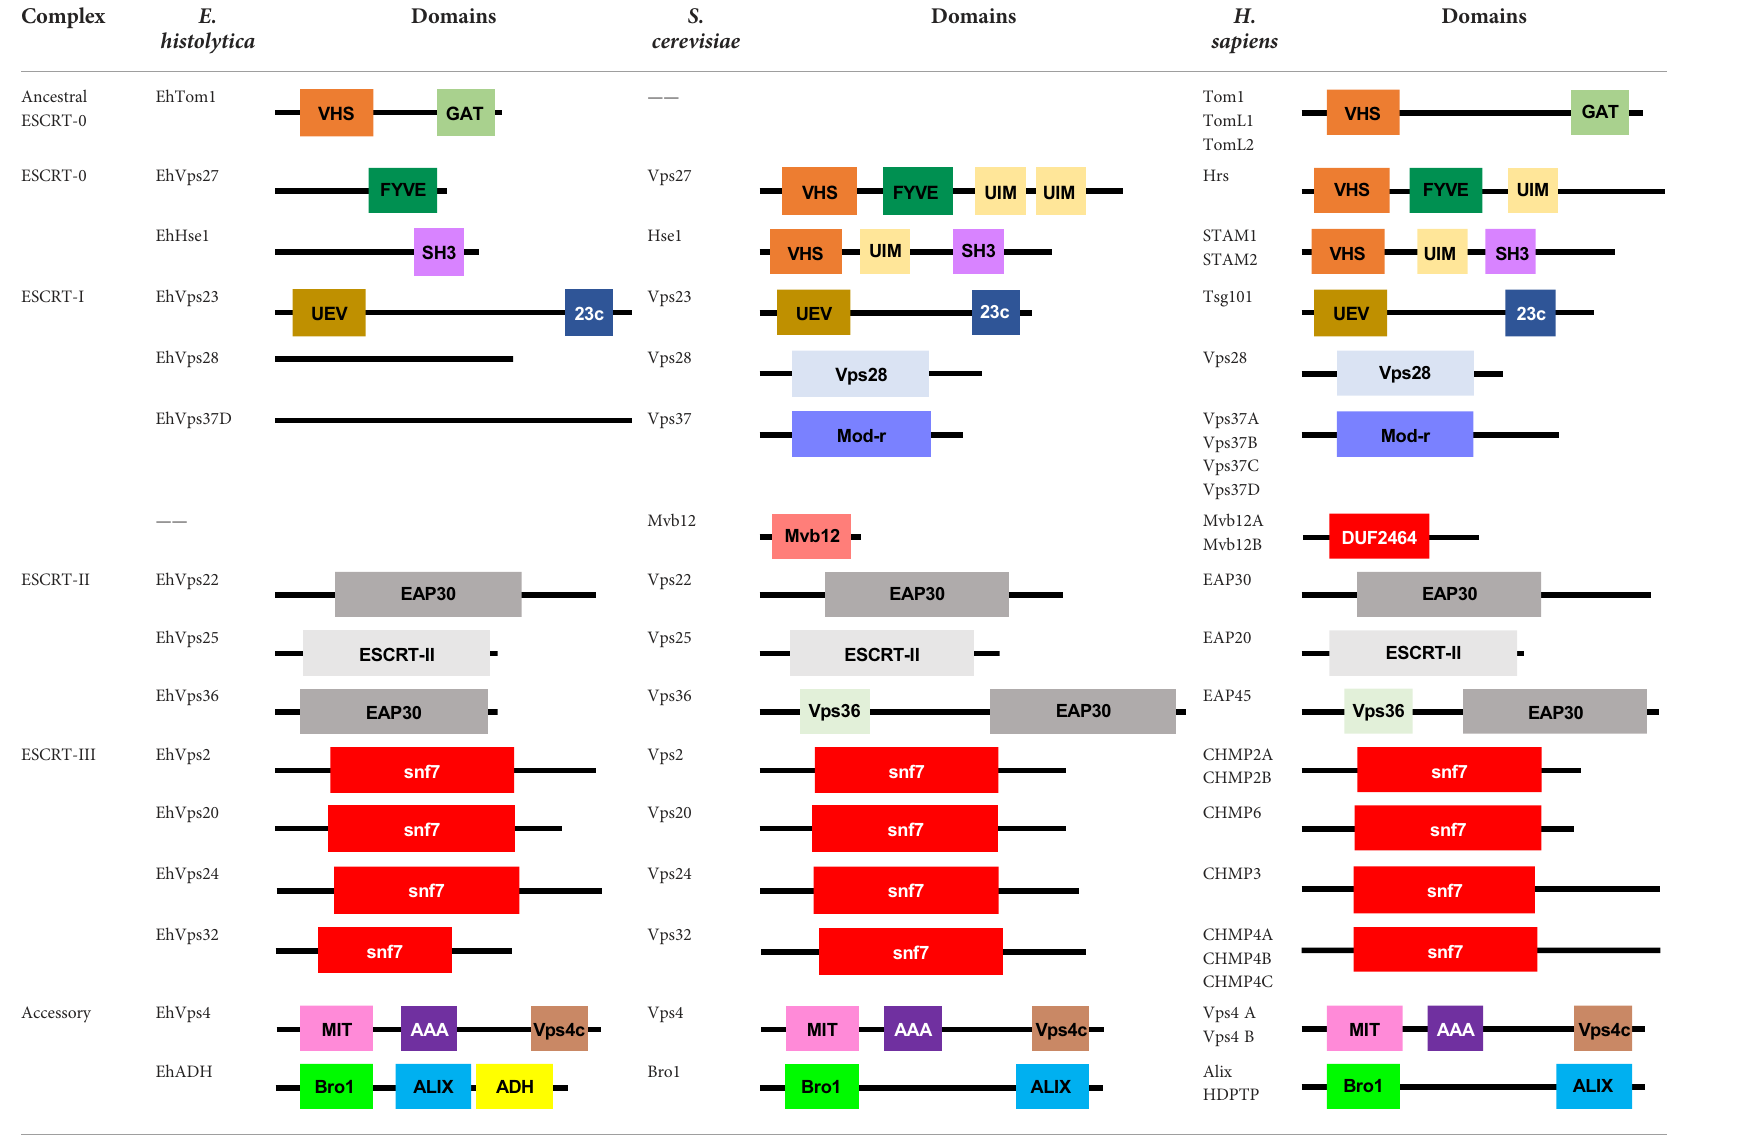
TABLE 1 Members of the ESCRT machinery in E. histolytica, H. sapiens and S. cerevisiae .